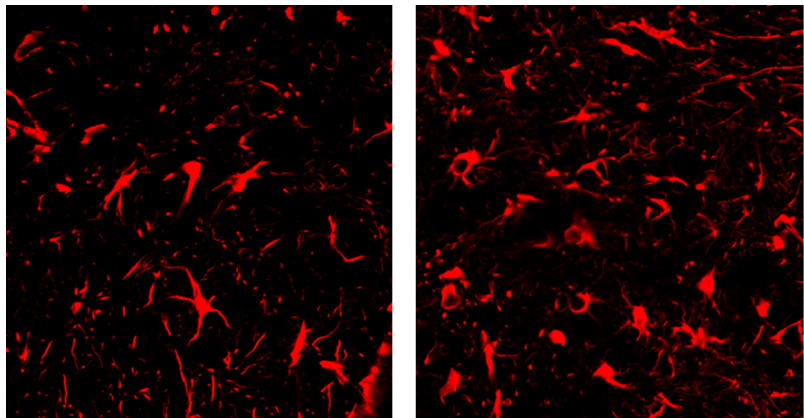
Figure 2. Positive expression of the immunofluorescence detection marker (GFAP).